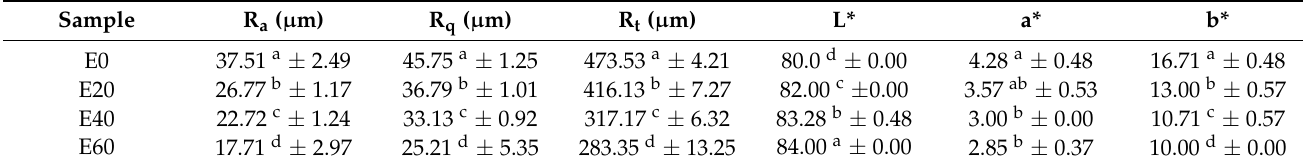
Figure 2. Optical profilometer images (surface 0.9 × 1.3 mm) of the obtained macaron samples. The largest roughness values are represented by the red regions and the smallest by the blue ones. Table 3. The surface roughness parameters and the color co-ordinates of the obtained macarons. R a —the average roughness, R q —the quadratic mean of surface roughness, R t —the maximum rough- ness height, L*—the brightness, a*: ± red-green, and b*: